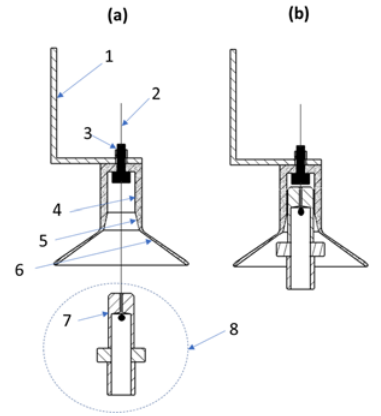
Figure 10. Docking system when ( a ) the measurement platform is undocked, and ( b ) the measure ‐ ment platform is docked. (1) Fixing element; (2) Holding line 0.3 mm; (3) Hardened M3 bolt with 0.8 mm hole and nut; (4) cylindrical stabilizing bore (diameter 10.2 mm); (5) Guiding cup 30 ◦ ; (6) Guiding cup 60 ◦ ; (7) Cylindrical stabilizing bolt (diameter 10 mm); (8) Quick mounting system for the measurement platform.